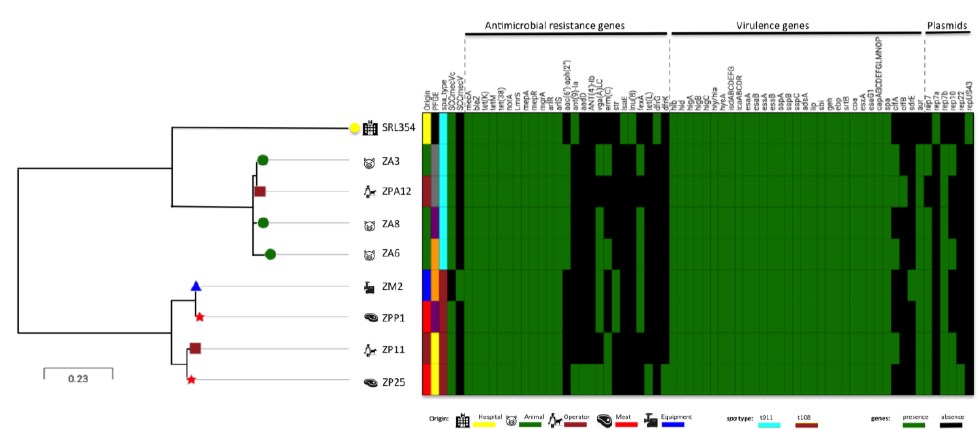
Figure 1. Comparison between hospital and slaughterhouse isolates based on single nucleotide polymorphisms (SNPs) identified through CSIPhylogeny v1.4 analysis. SNPs tree visualization was performed with Microreact server. Green boxes indicate the presence of acquired antimicrobial resistance genes, virulence genes or the molecular characteristic indicated in the Figure. Black boxes indicate the absence of genetic determinants.